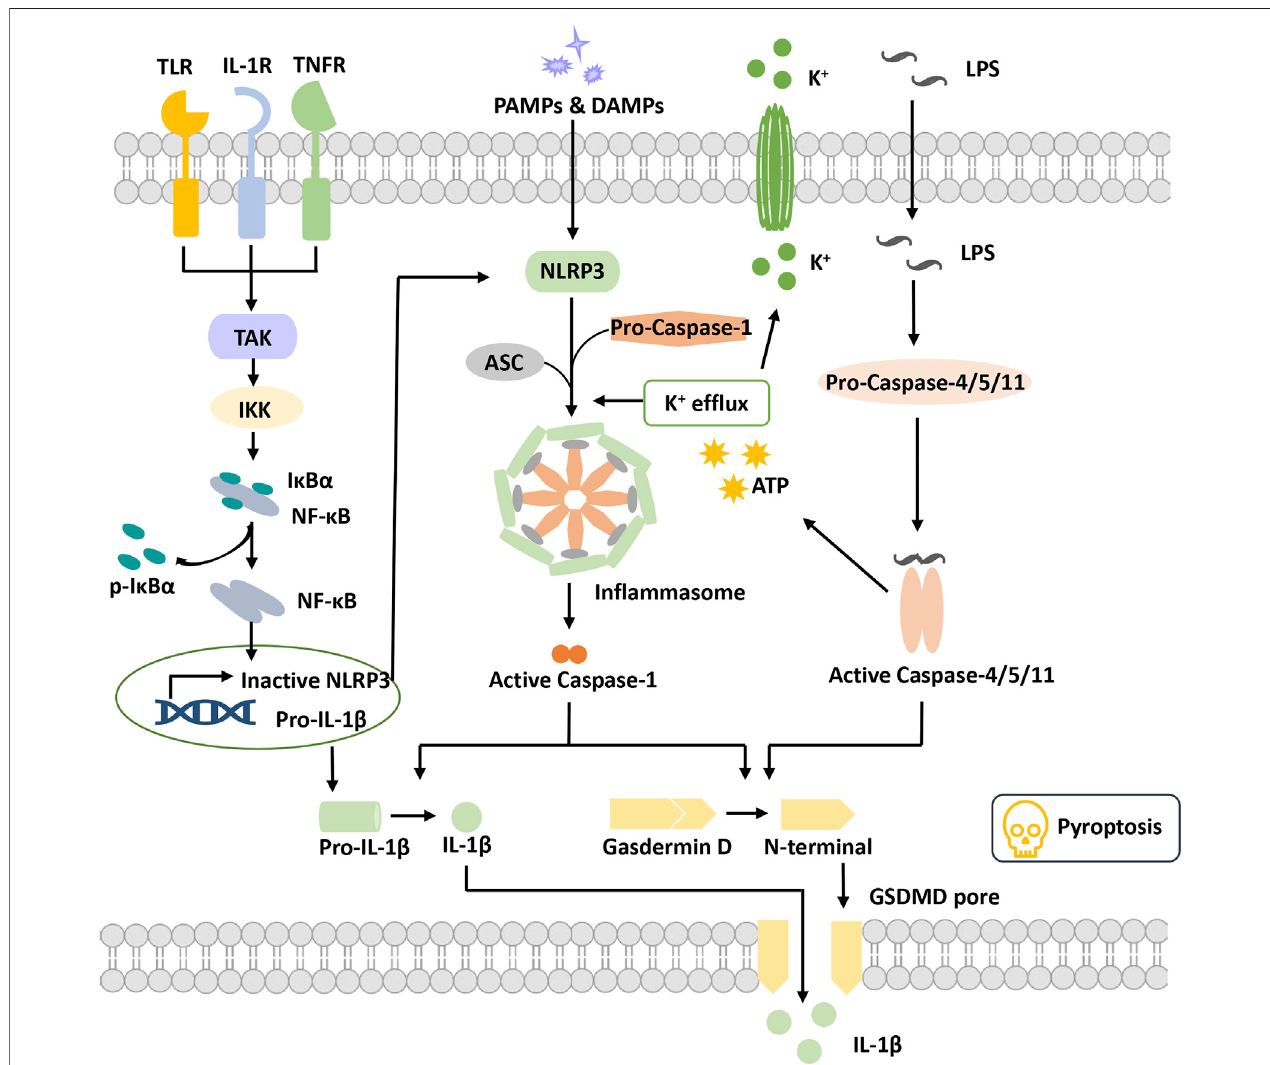
FIGURE 1| Overview of pyroptosis. Pyroptotic priming signals are usually triggered by endogenous cytokines and activate the NF- κ B signaling pathway to induce the transcription of inactive NLRP3 and pro-IL-1 β . Activation signals are triggered by the stimulation of DAMPs or PAMPs, stimulating NLRP3 oligomerization to recruit ASC and pro-caspase-1 and then form the NLRP3 in fl ammasome. Activated caspase-1 cleaves GSDMD to release the N-terminal domain and form the plasma membrane pore, leading to pyroptosis. Activated caspase-1 promotes the maturation and secretion of IL-1 β . In addition, LPS binds to pro-caspase-4/5/11 to activate it, inducing pyroptosis via cleavage of GSDMD and formation of pores. Activated caspase-4/5/11 can also induce K+ ef fl ux and activate the NLRP3 in fl ammasome. Abbreviations: ASC, apoptosis speck-like protein; DAMPs, damage-associated molecular patterns; GSDMD, gasdermin D; IKK α / β , IkB kinase α / β ; IL- 1 β , interleukin-1 β ; LPS, lipopolysaccharide; PAMPs, pathogen-associated molecular patterns; TAK1, beta-activated kinase 1; TLR, toll-like receptor.